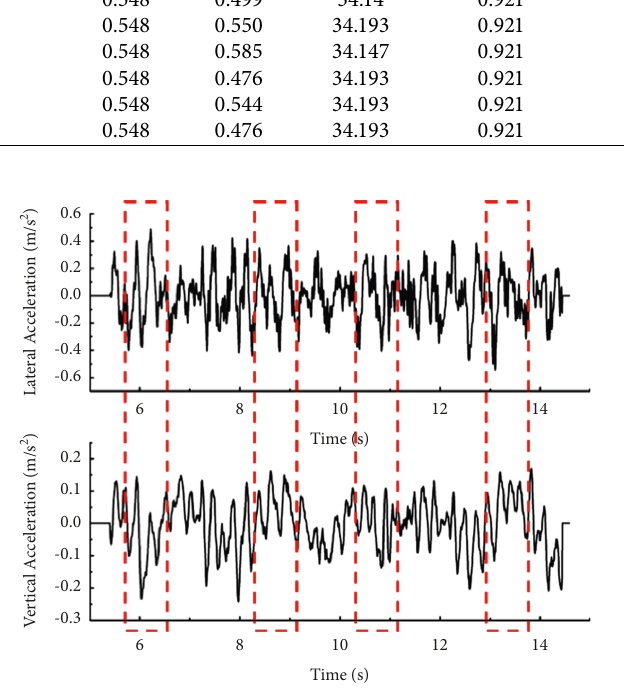
Figure 16: Time histories of acceleration of the last car-body in Case1.